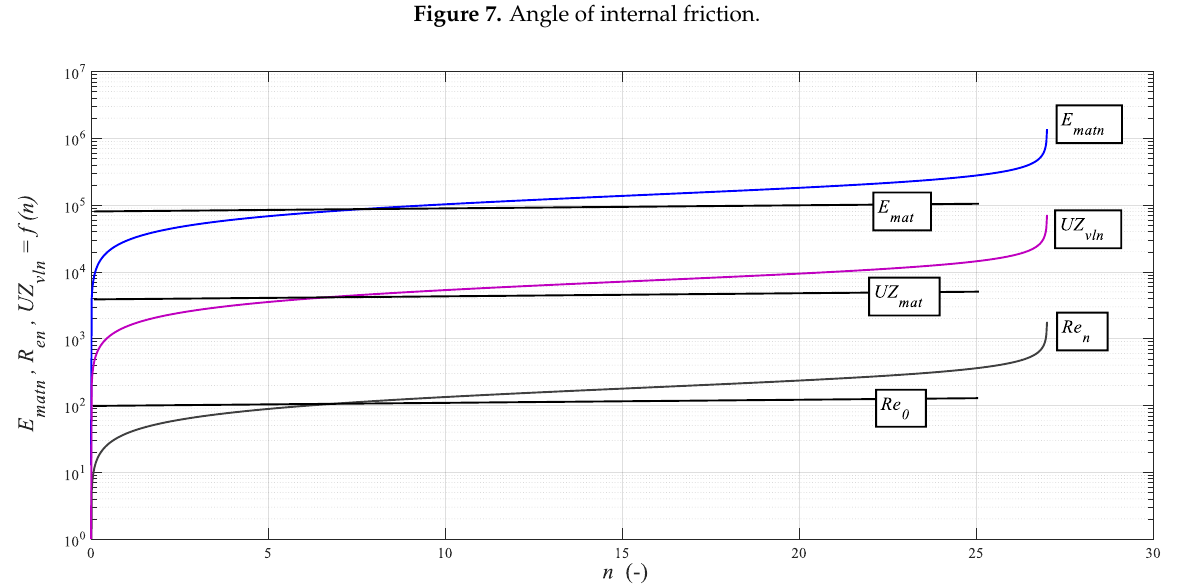
Figure 8. Dependence of functions E matn , Re n , UZ vln = f ( n ).